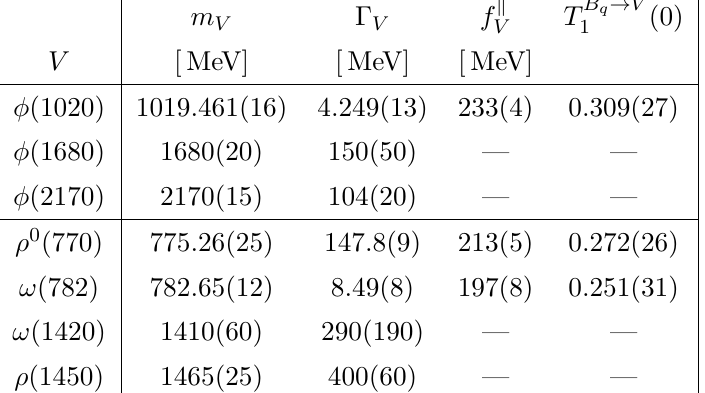
— — Table 2 . Numerical input values for the parameters of the resonances entering the b → s and b → d transitions. Masses and decay widths are from [47] and decay constants and form factors from [45], with the q 2 dependence of T B q → V in the simplified series expansion (SSE) in table 14 1 from light-cone sum rules